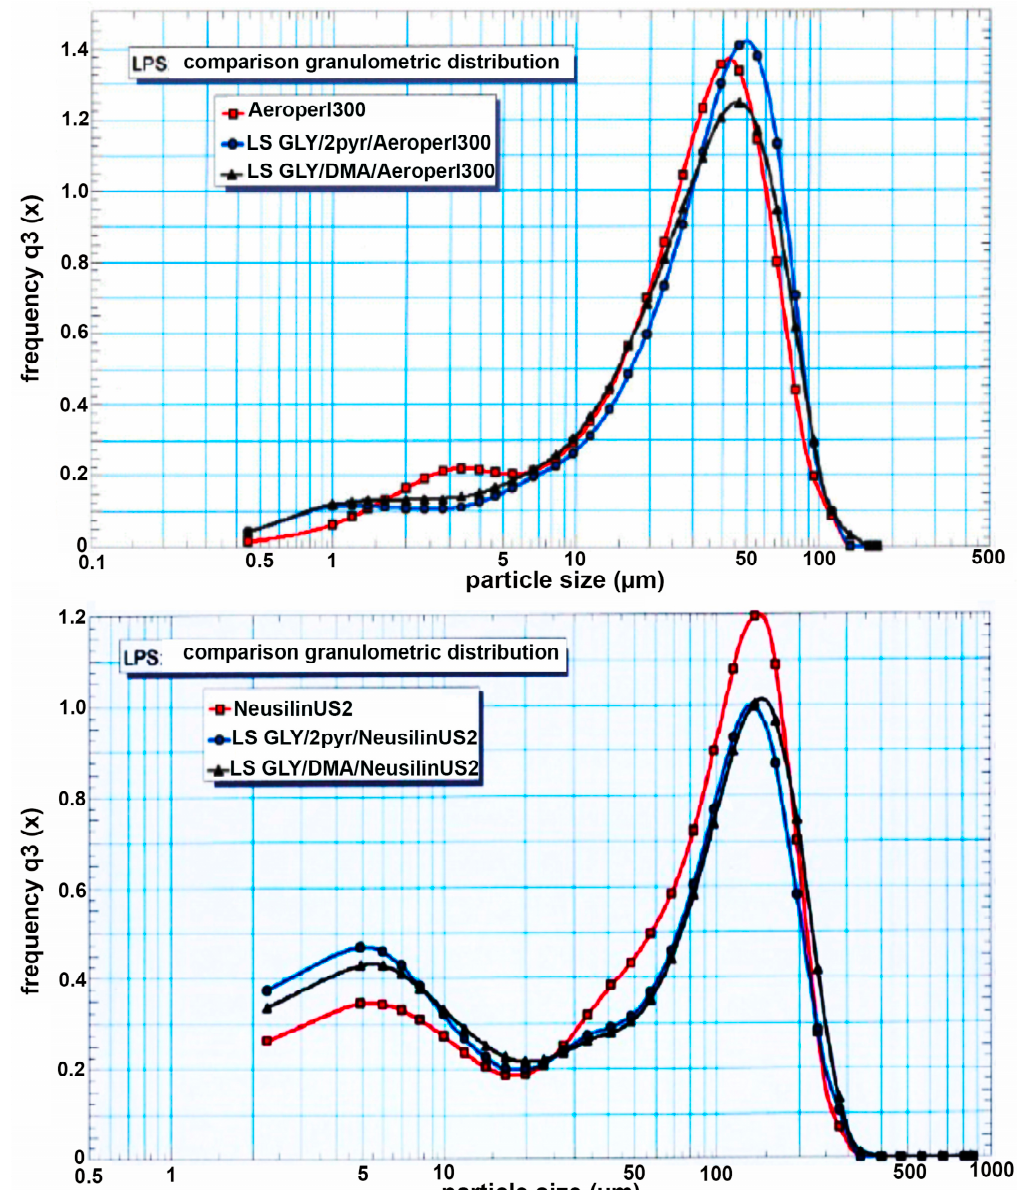
Figure 2. Granulometric analysis, by Laser Particle Size (LPS), of pure Aeroperl ® 300 and Neusilin ® US2, and of the corresponding liquisolid systems with glyburide (GLY) containing 2-pyrrolidone (2-PYR) or dimetylacetamide (DMA) as non-volatile water miscible solvent.